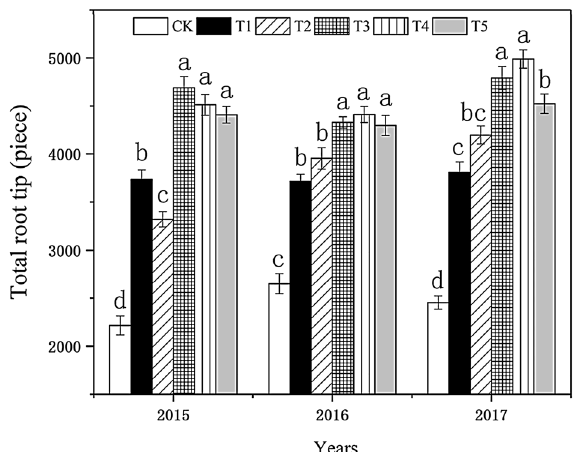
Figure 3. Effect of biochar treatment on the total root tips of tobacco. Note: Six biochar application levels: CK = 0 kg/ha, T1 = 600 kg/ha, T2 = 1200 kg/ha, T3 = 1800 kg/ha, T4 = 2400 kg/ha, T5 = 3000 kg/ha; The error bars are standard deviation; different letters on the error lines indicate significant differences between different treatments (α = 0.05).